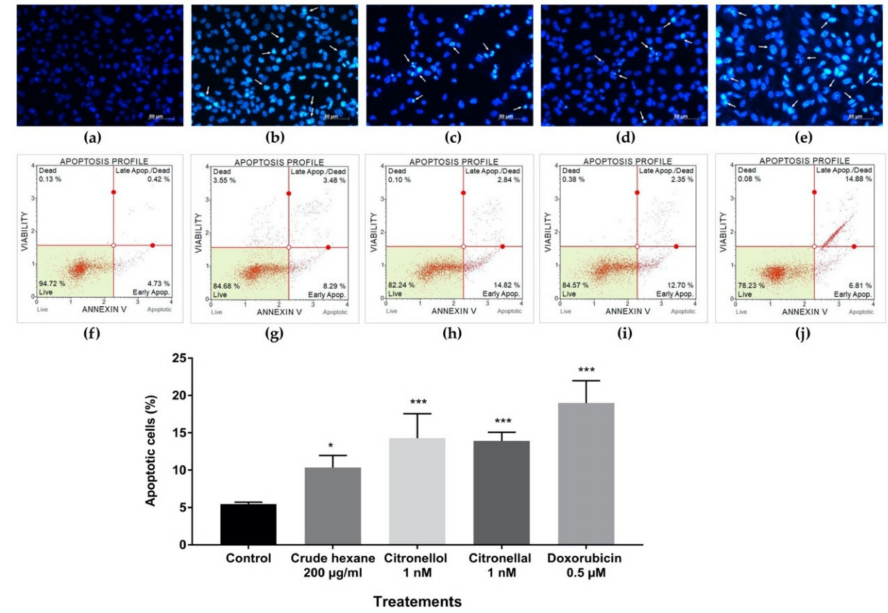
Figure 6. Hoechst 33342 staining showing chromatin condensation and DNA fragmentation in apoptotic cells under treatment of ( a ) control, ( b ) crude hexane extract 200 µ g / mL, ( c ) citronellol 1 nM, ( d ) citronellal 1 nM, ( e ) doxorubicin 0.5 µ M. Apoptotic MDA-MB-231 cells using Annexin-V and 7-AAD staining under treatment of ( f ) control, ( g ) crude hexane extract 200 µ g / mL, ( h ) citronellol 1 nM, ( i ) citronellal 1 nM, ( j ) doxorubicin 0.5 µ M. Data are presented as means ± SEM. One-way ANOVA with Dunnett’s multiple comparisons test was used to analyze the di ff erence between control and treatment groups, p value < 0.05 considered significant (* p < 0.05, *** p < 0.001).